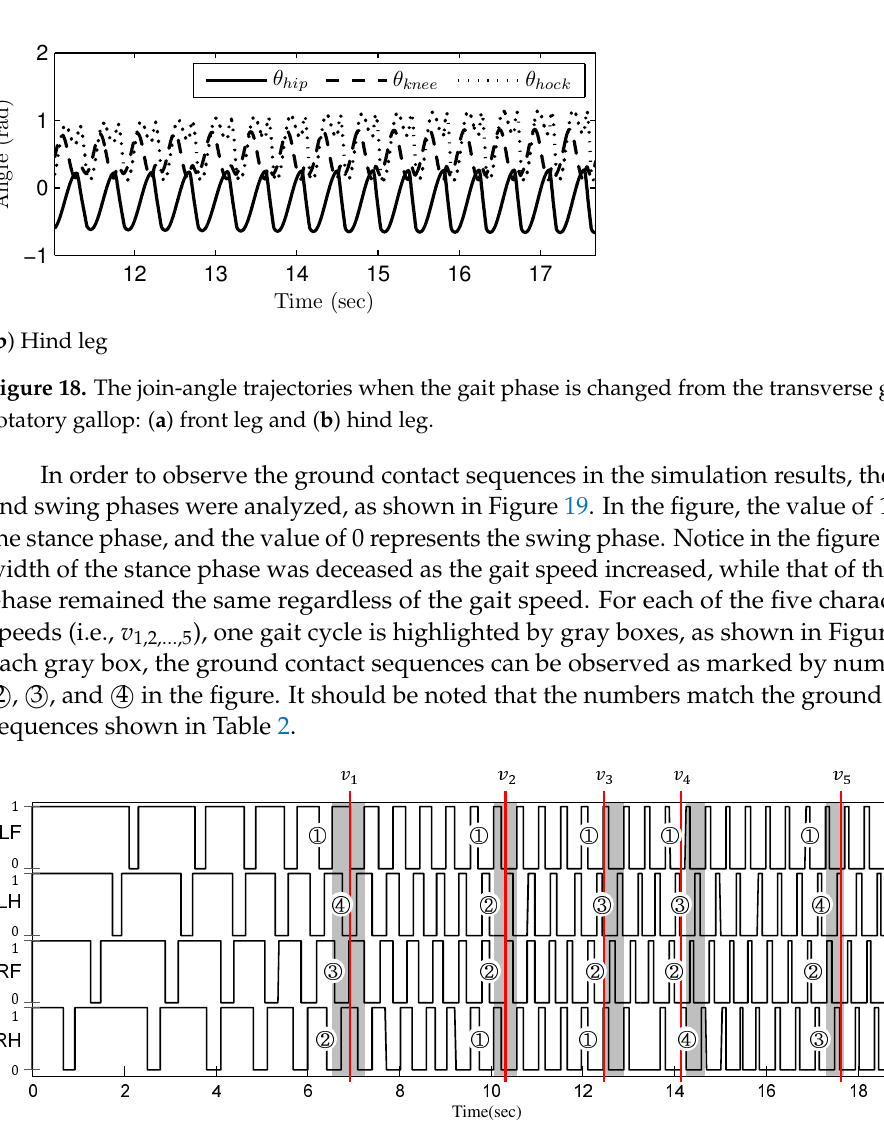
Figure 19. The ground contact indicators of four feet with respect to the